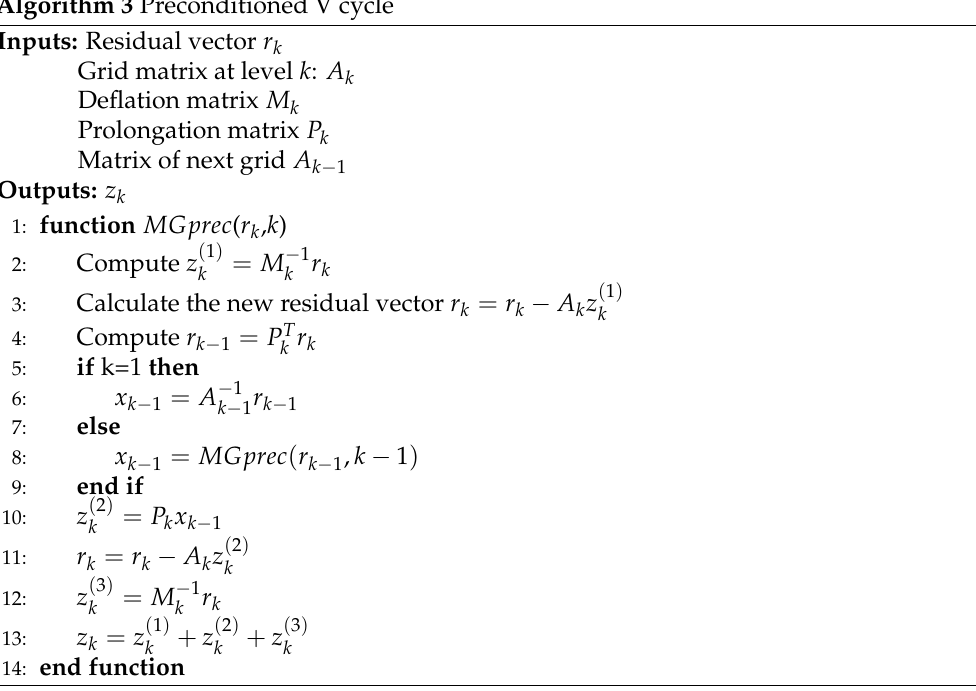
Algorithm 3 Preconditioned V